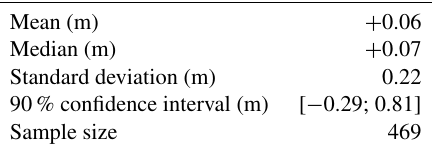
Table 3. DEM altimetric error statistics.